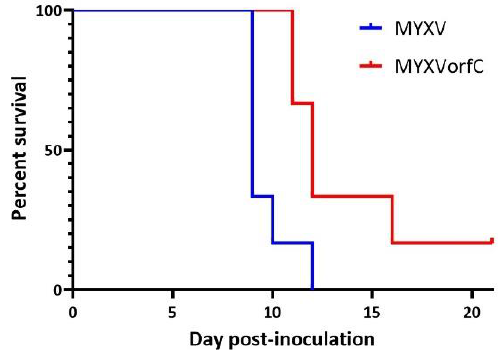
Figure 7. The median survival time of rabbits infected with 50 pfu MYXV was significantly shorter than that of rabbits infected with 50 pfu MYXVorfC (( n = 6 per group, p -value = 0.014).